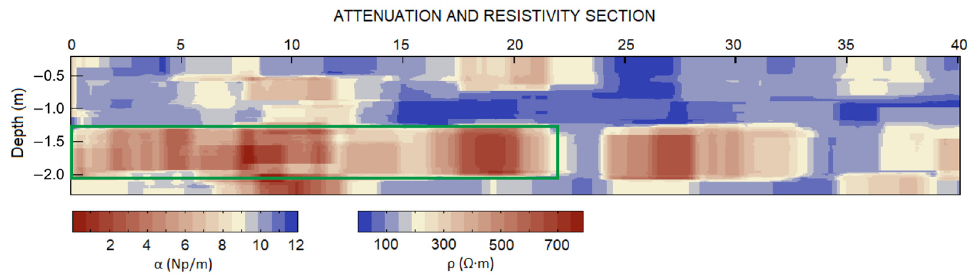
Figure 15. Example of a section showing the variation of attenuation coefficient and resistivity values obtained from Equation (8).